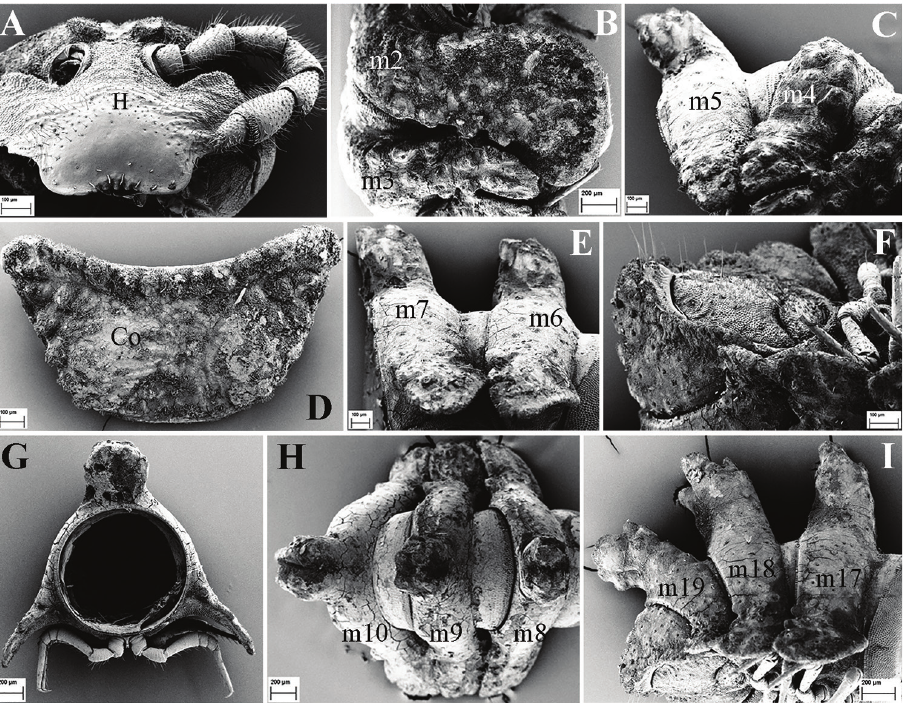
Figure 2. E. steineri sp. n., SEM, male paratype from Cave Tham Deu. A head (H) and left antenna, frontal view B segments 2 and 3, lateral view C. segments 4 and 5, lateral view (m2–m5 = metaterga 2–5) D collum (Co), dorsal view E segments 6 and 7, lateral view (m6–m7 = metaterga 6, 7) F telson, subven- tral view G cross-section of segment 11, caudal view H segments 8–10, dorsal view I segments 17–19 and telson, lateral view (m8–m10, m17–m19 = metaterga 8–10,